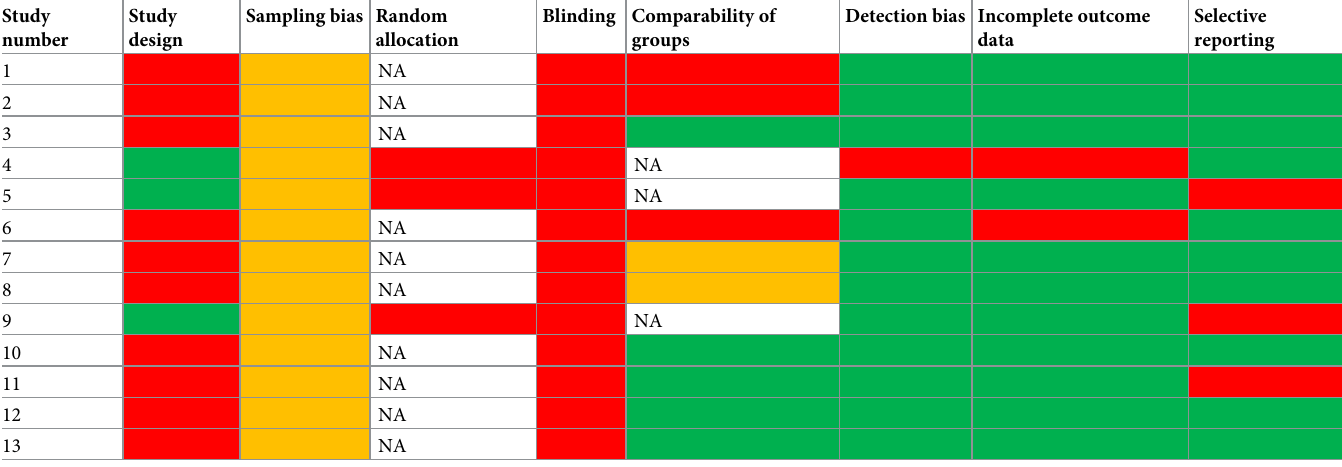
Table 4. Summary of bias for the included